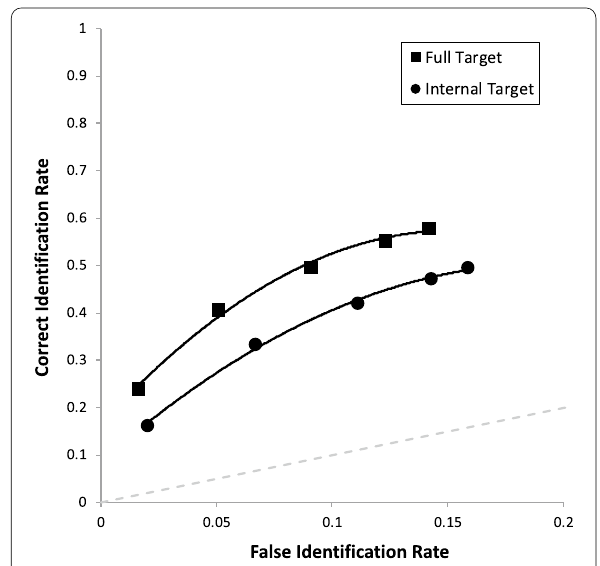
Fig. 2 ROC curve for full targets versus internal targets (i.e., our encoding manipulation), collapsed over all other